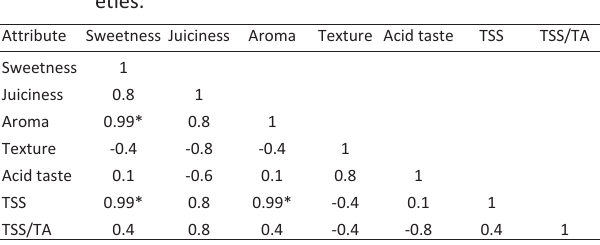
Table 6 - Spearman’s coefficients among sensory (sweetness, juiciness, aroma, texture, acid taste) and physicochem- ical (TSS, TSS/TA) variables for the tested peach vari- eties.